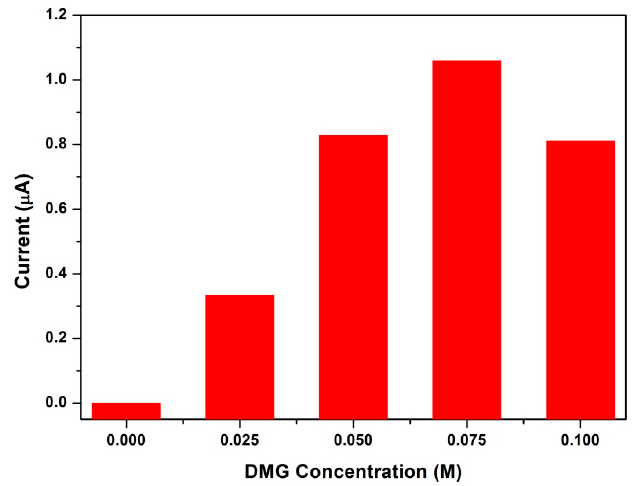
Figure 12. Influence of dimethylglyoxime concentration (0–0.1 M) on the stripping peak currents of Ni 2+ at the NGr-DMG-GCEs in 0.1 M NH 3 /NH 4 Cl buffer (pH 9.3).